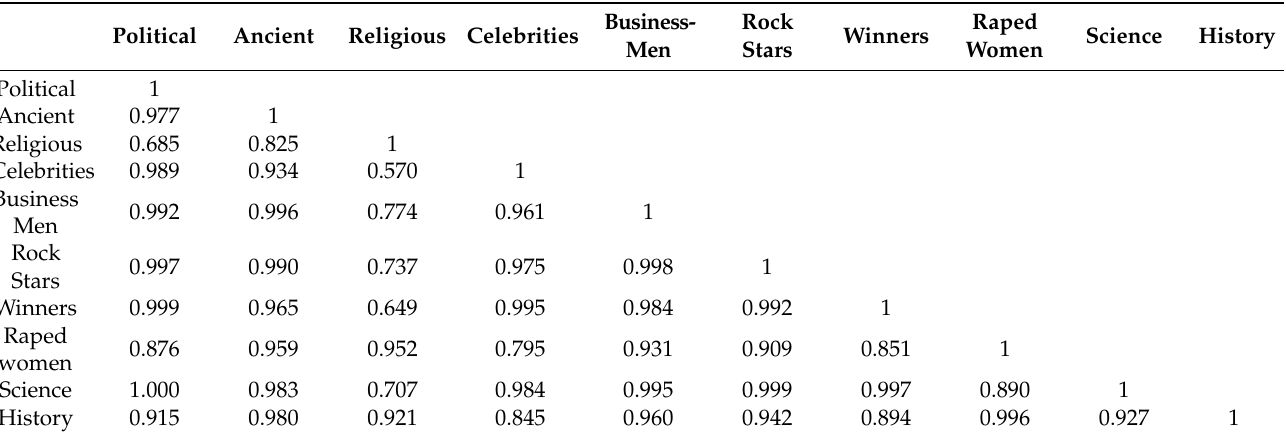
Table 7. The correlation matrix of the different categories regarding the measures of